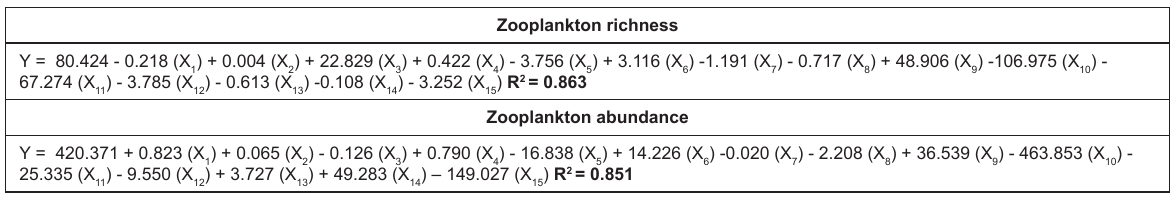
water temperature (X phosphate